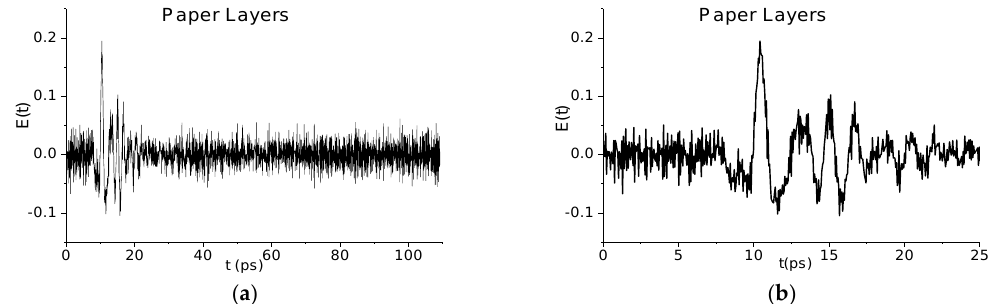
Figure 2. THz signal Paper Layers in the time interval t = [0, 110] ps. ( a ); [0, 25] ps. ( b ) [29].